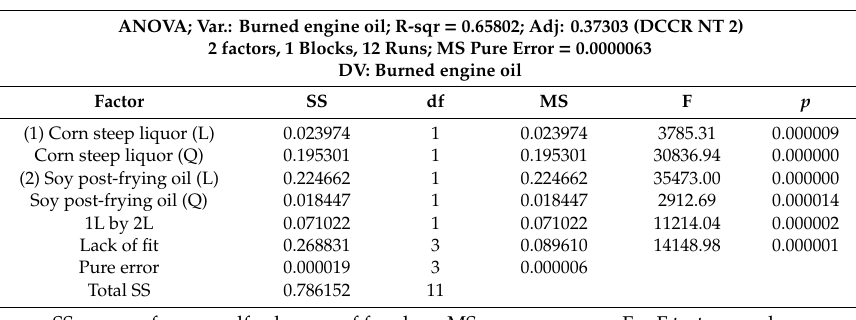
Table 4. ANOVA results for the quadratic model of AE in burned engine oil. ANOVA; Var.: Burned engine oil; R-sqr = 0.65802; Adj: 0.37303 (DCCR NT 2) 2 factors, 1 Blocks, 12 Runs; MS Pure Error = 0.0000063